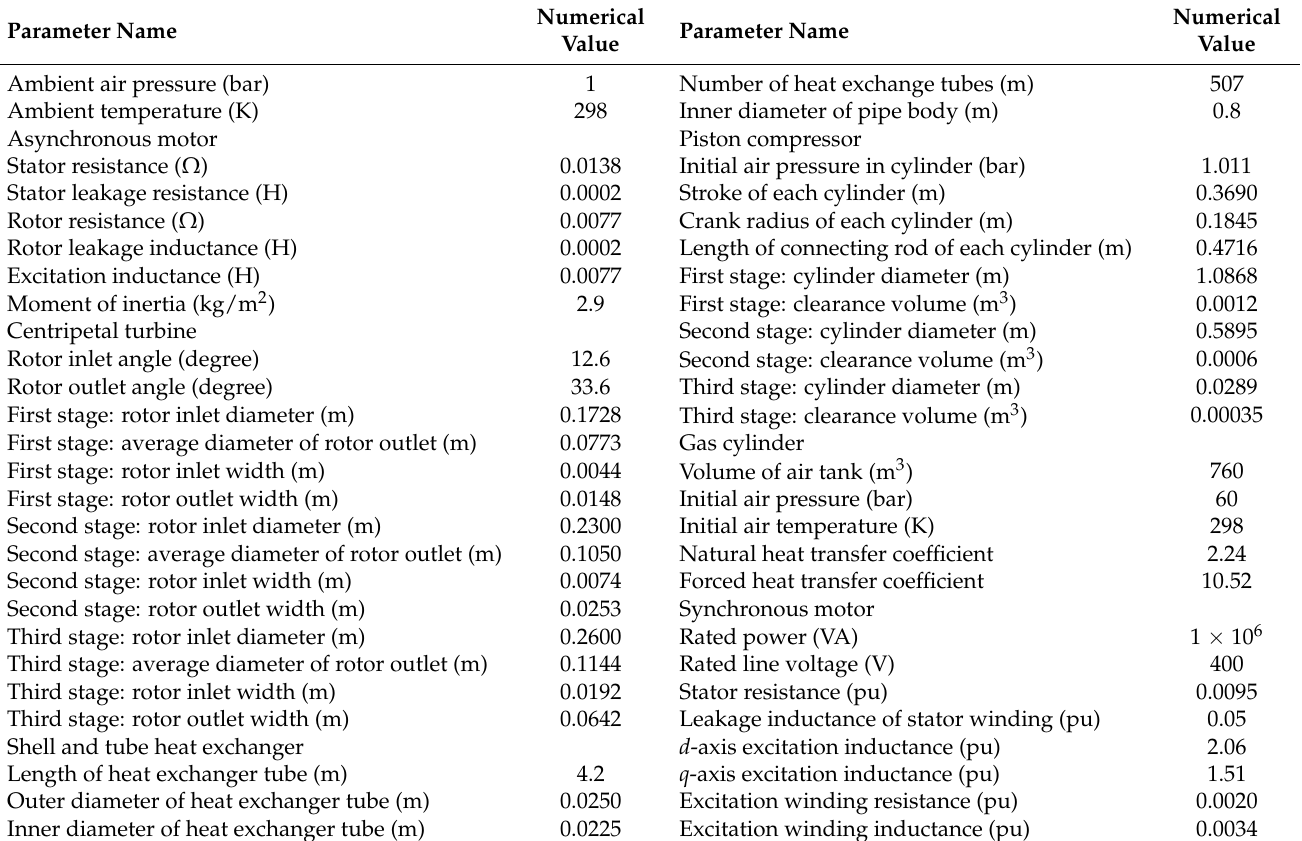
Key parameters of main components of the AA-CAES system are shown in Table 5. Table 5. Key parameters of main components of the AA-CAES system.